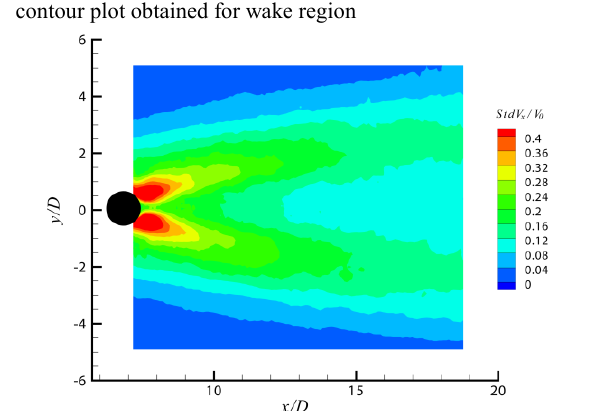
Fig. 12. Normalized mean transverse velocity component contour plot obtained for wake region